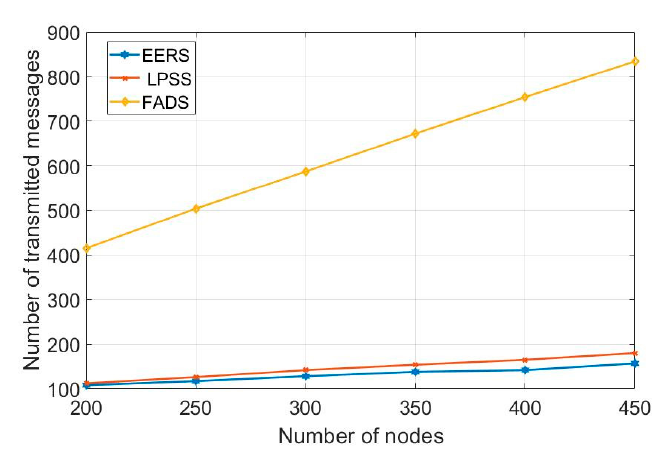
Figure 7. Required number of messages for reference node scheduling process (r = 85 m, N = 200: 450).